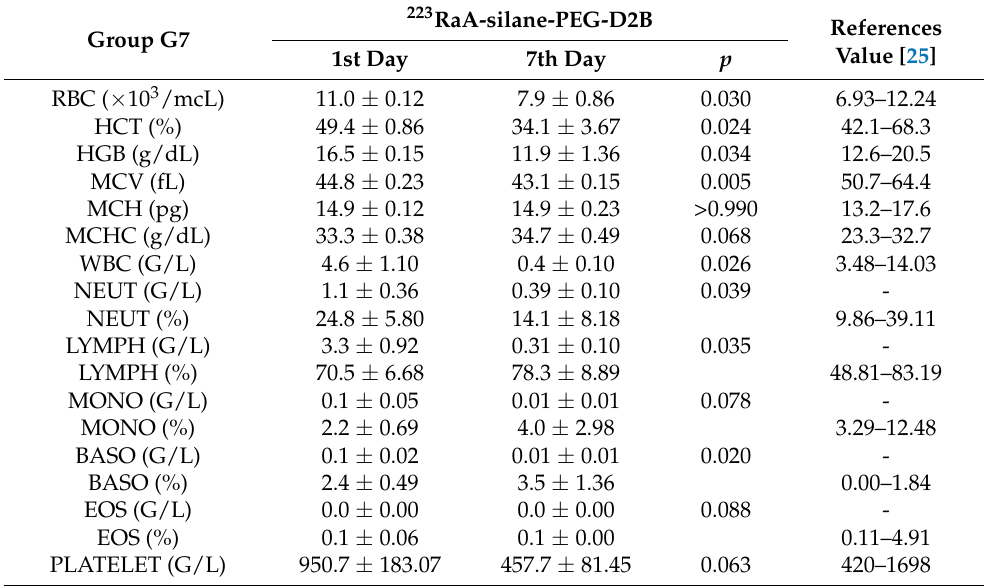
Table A7. Hematological parameters of blood of BALB/c mice at 1 and 7 days after injection with